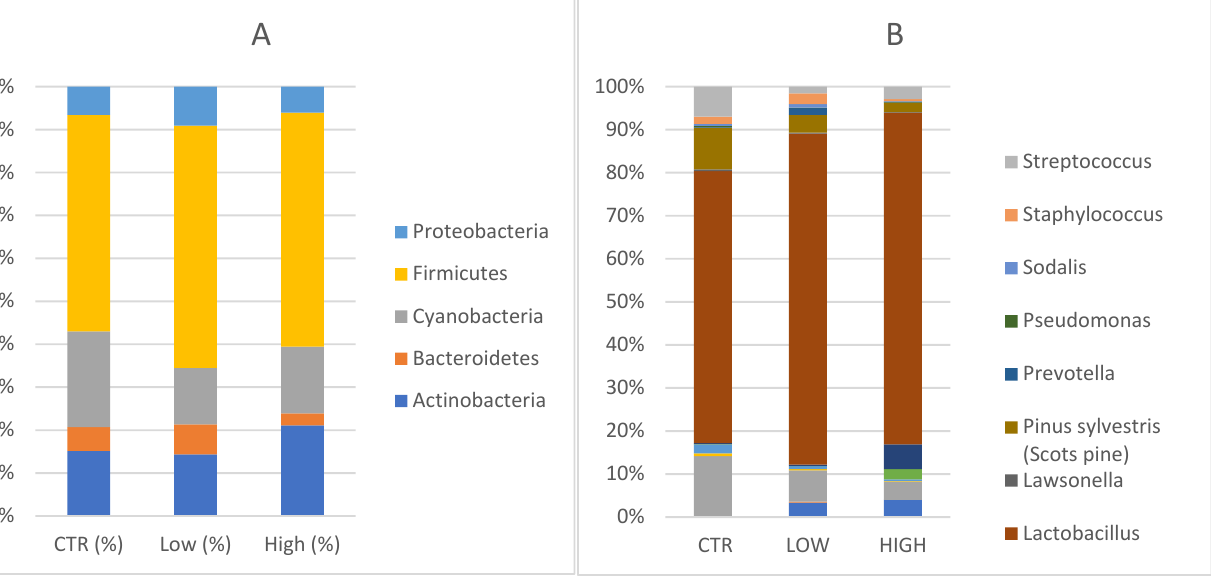
Figure 2. ( A ) Phylum level: Relative abundance detected in endometrial samples. CTR = control; Low = HLA- DQ2/DQ8 negative-RPL; High= HLA-DQ2/DQ8 positive-RPL. ( B ) Genus level: Relative abundances detected in endometrial samples. Legenda: CTR = control; Low= HLA-DQ2/DQ8 negative-RPL; High: HLA-DQ2/DQ8 positive-RPL.